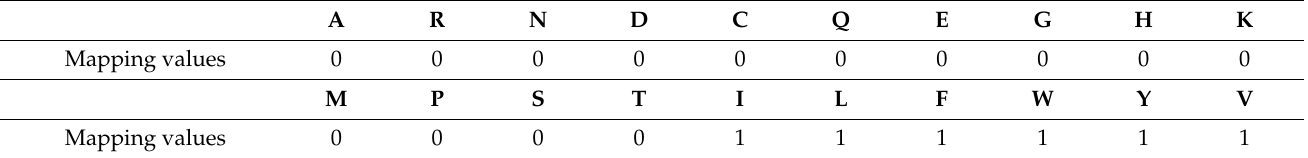
Table 1. Mapping values of topological